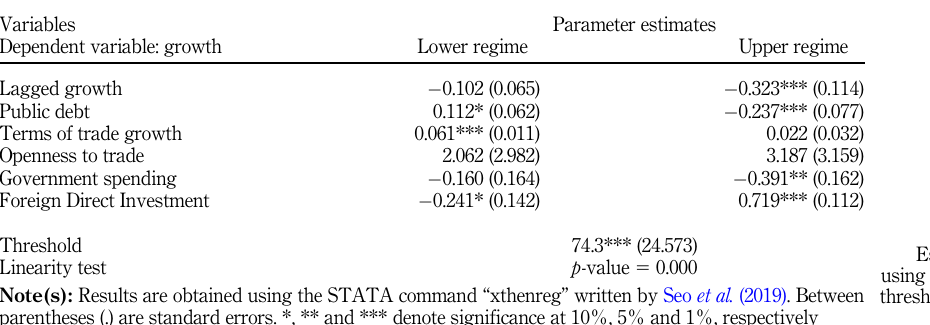
Table 11. Estimation